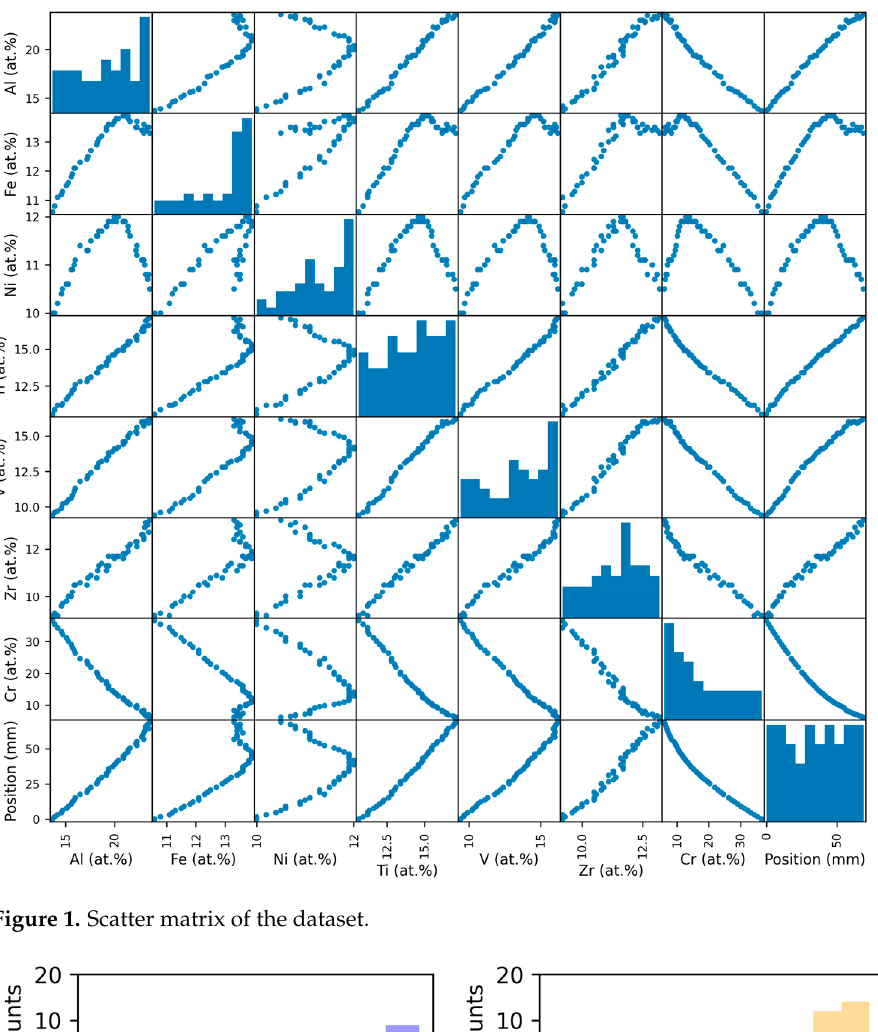
Figure 1. Scatter matrix of the dataset.